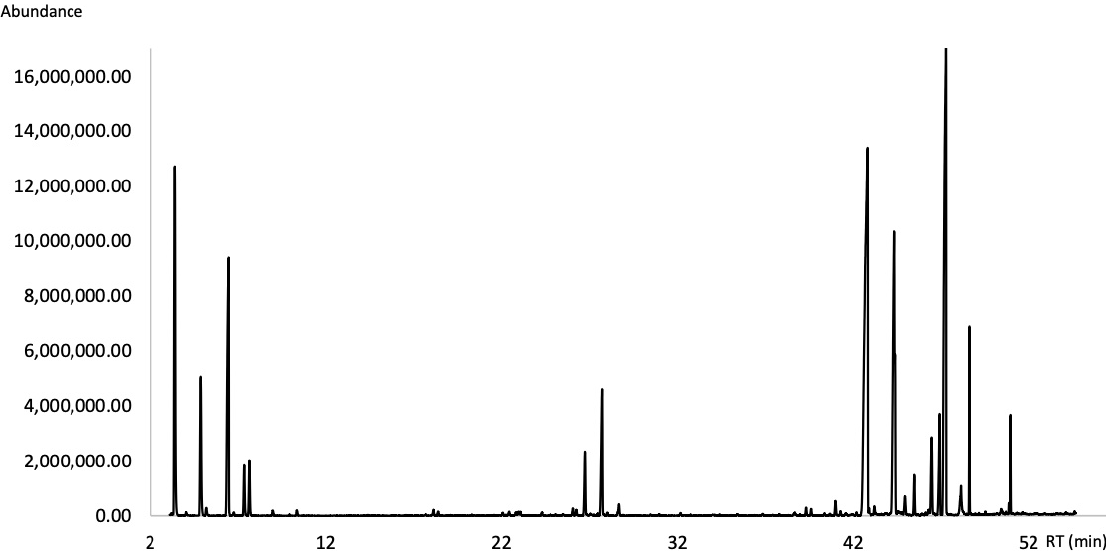
Figure 2. Gas chromatogram of the leaf essential oil of A. brasiliensis on a HP-INNOWax column.